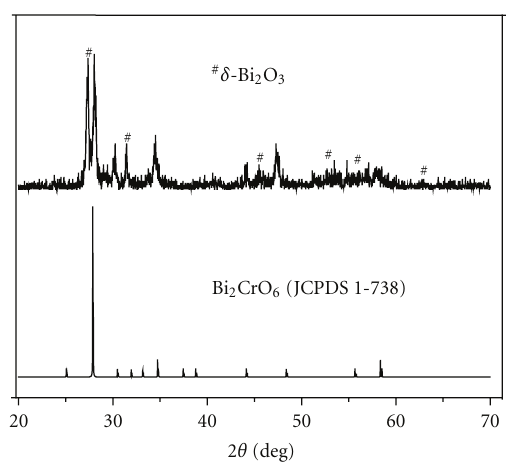
Figure 1: XRD pattern of the composite Bi 2 O 3 -Bi 2 CrO 6